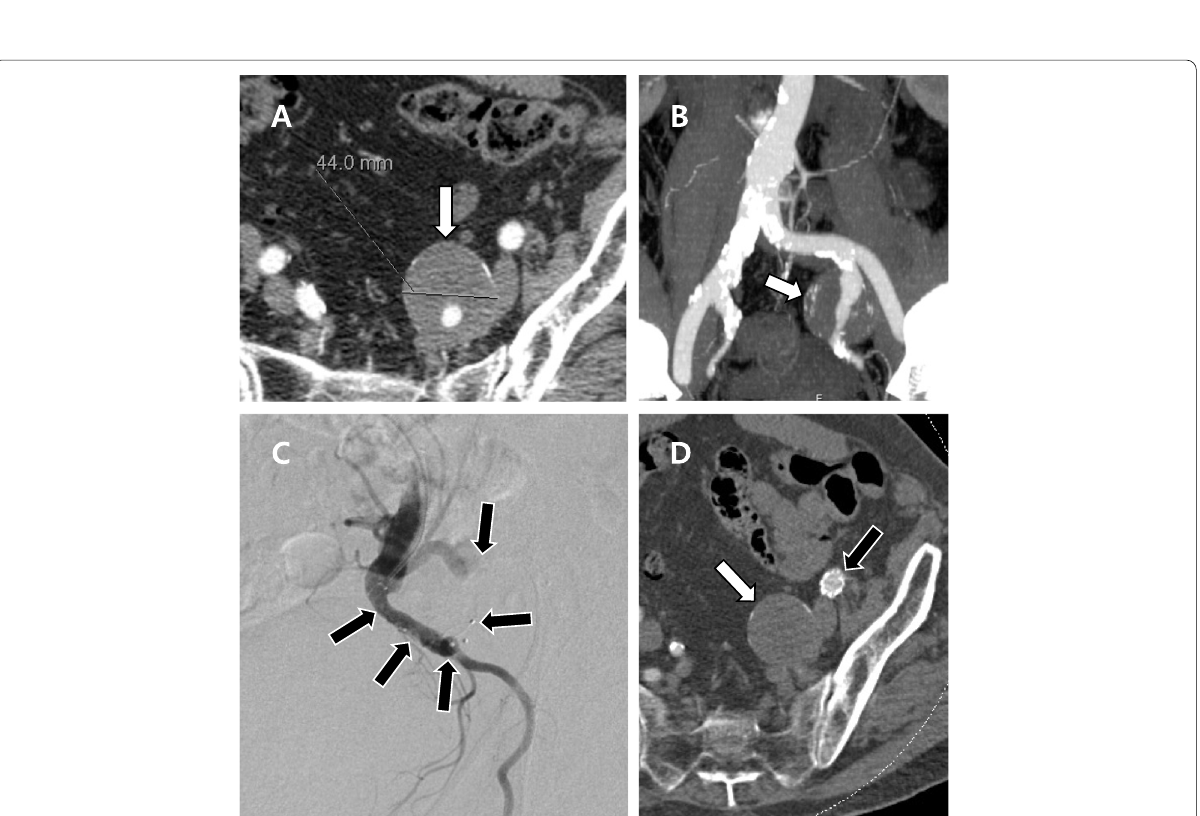
Fig. 3 Successful endovascular treatment of an isolated IIA aneurysm in a 72‑year‑old, male patient. A and B CT scan demonstrates an IIA aneurysm measuring 44 mm in diameter (white arrow). C Vascular plugs (black arrows) were deployed in the outflow branches. The ostium of the internal iliac artery was covered by deploying an iliac stent graft (not shown). D CT at 3 months follow‑up demonstrates complete thrombosis of the aneurysm sac (white arrow) without endoleak. Patency of the iliac stent‑graft (black arrow) is